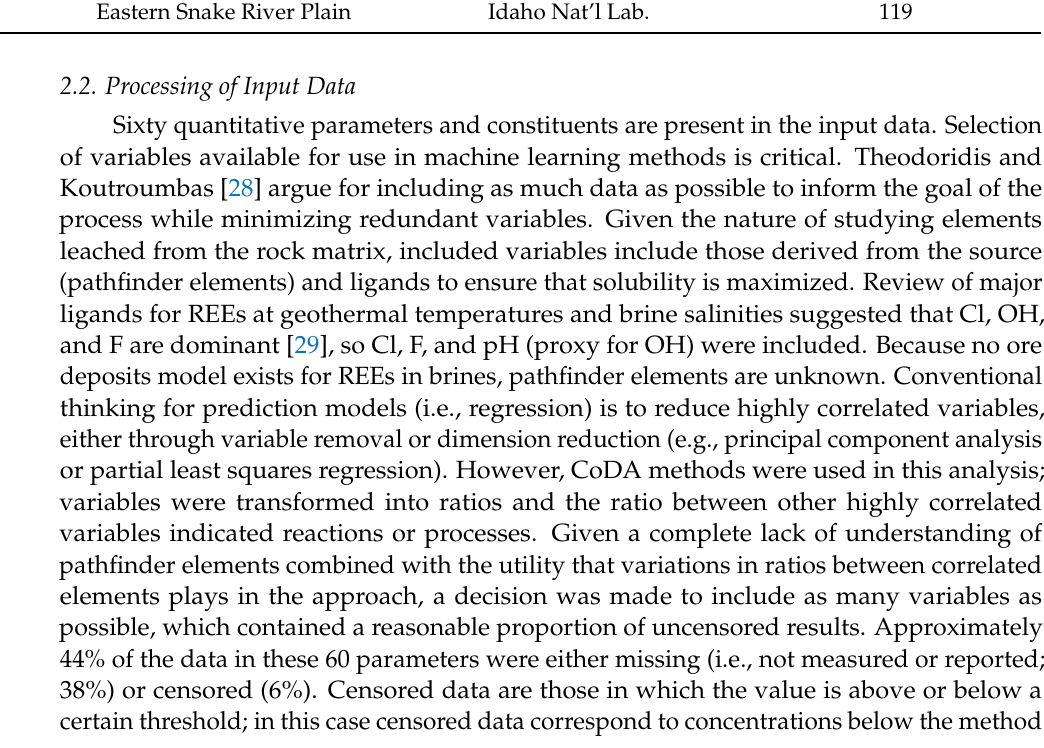
Table 1. Source and number of water samples used in the input dataset for the REE prediction